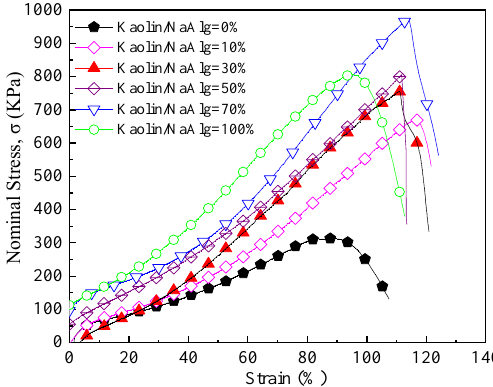
Figure 3. Mechanical properties of composite membrane prepared with different kaolin content.